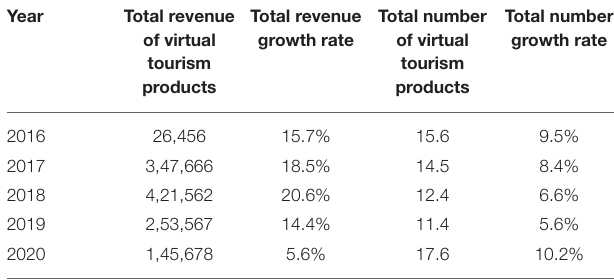
TABLE 2 | Development of virtual